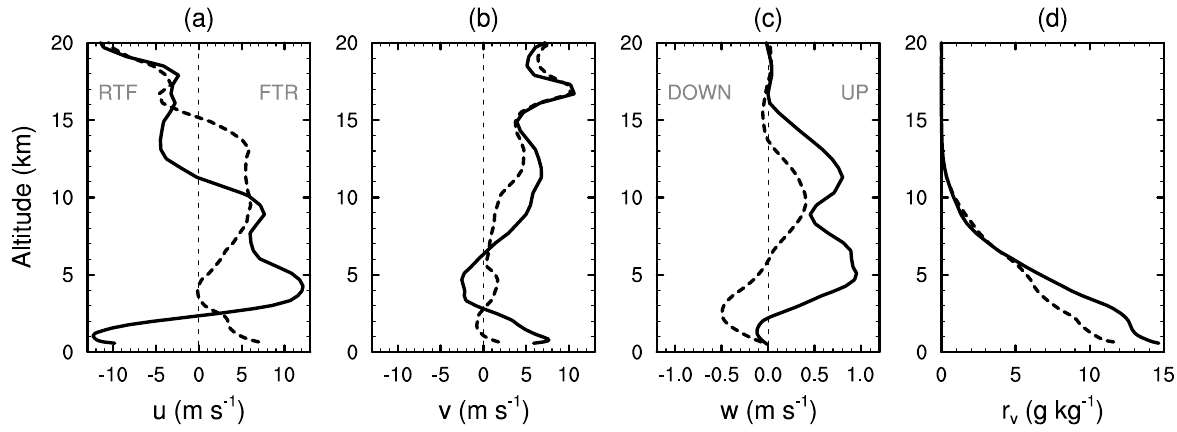
Fig. 7. (a) Cross line ( u ) and (b) along line ( v ) relative wind components, (c) vertical velocity ( w ), and (d) water vapor mixing ratio ( r v ) profiles on 15 August 2004 at 19:00UTC averaged over the convective (solid lines) and stratiform (dashed lines) regions defined in Fig. 6. In (a) , negative and positive cross-line winds correspond to rear-to-front (RTF) and front-to-rear (FTR) flow, respectively. In (c) , UP and DOWN stand for upward and downward motion,